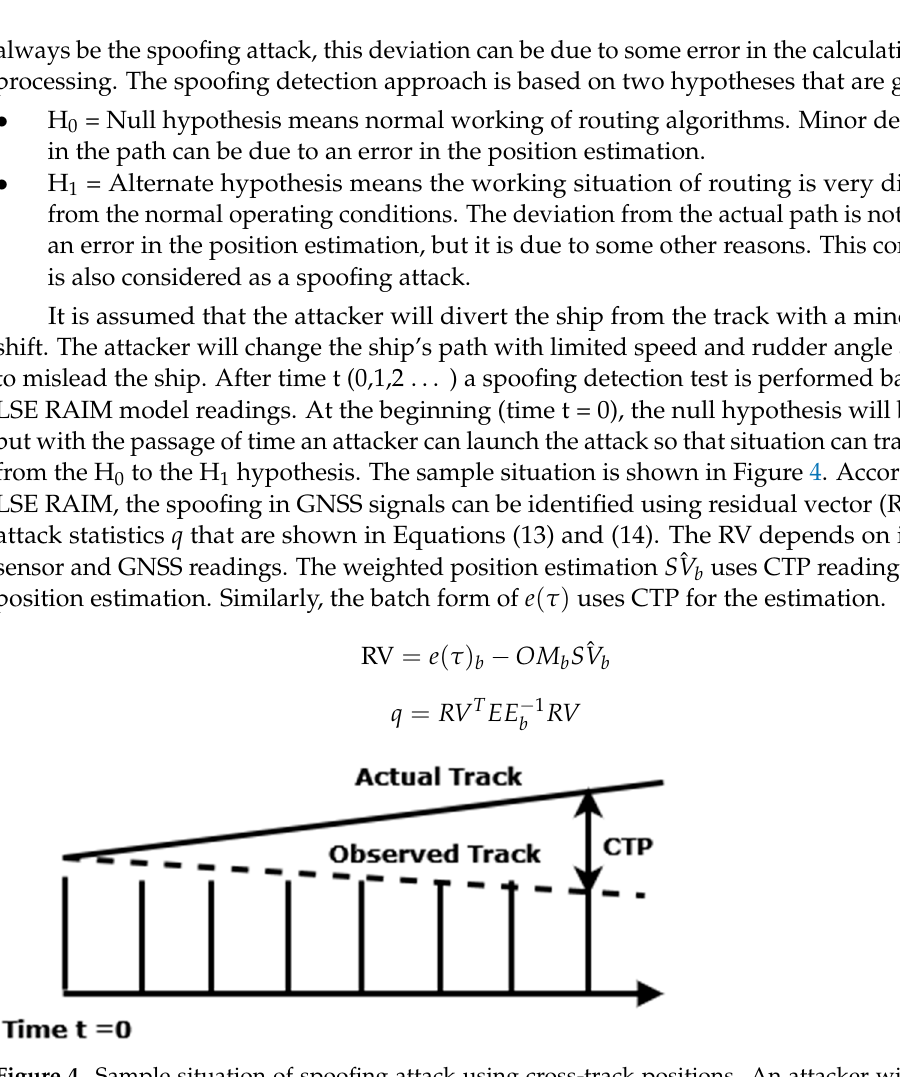
(cid:3043) is proportional gain of PID, and